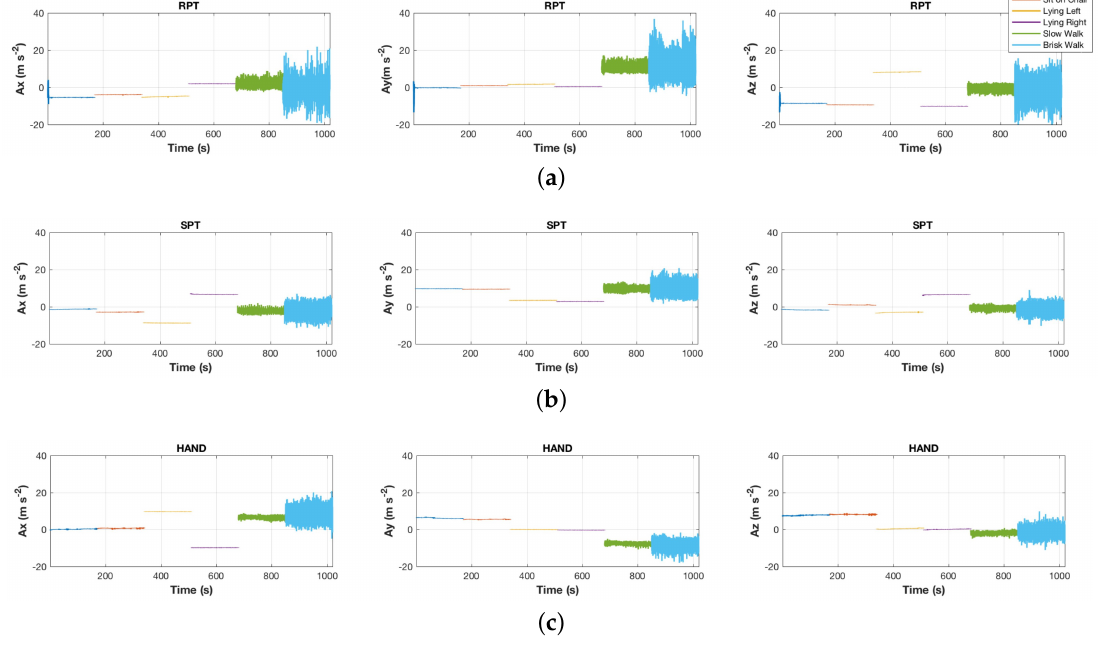
Figure 3. Raw accelerometer readings collected from a smartphone kept in three different positions for detailed activities. ( a ) device kept in Right Pants pockeT (RPT); ( b ) device kept in the Shirt PockeT (SPT); ( c ) device kept in the right hand (Hand).